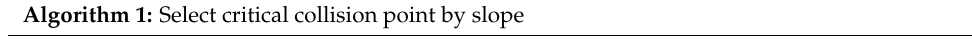
8 of 21 Figure 5. Velocity obstacle cone of the target ship in polar coordinates .